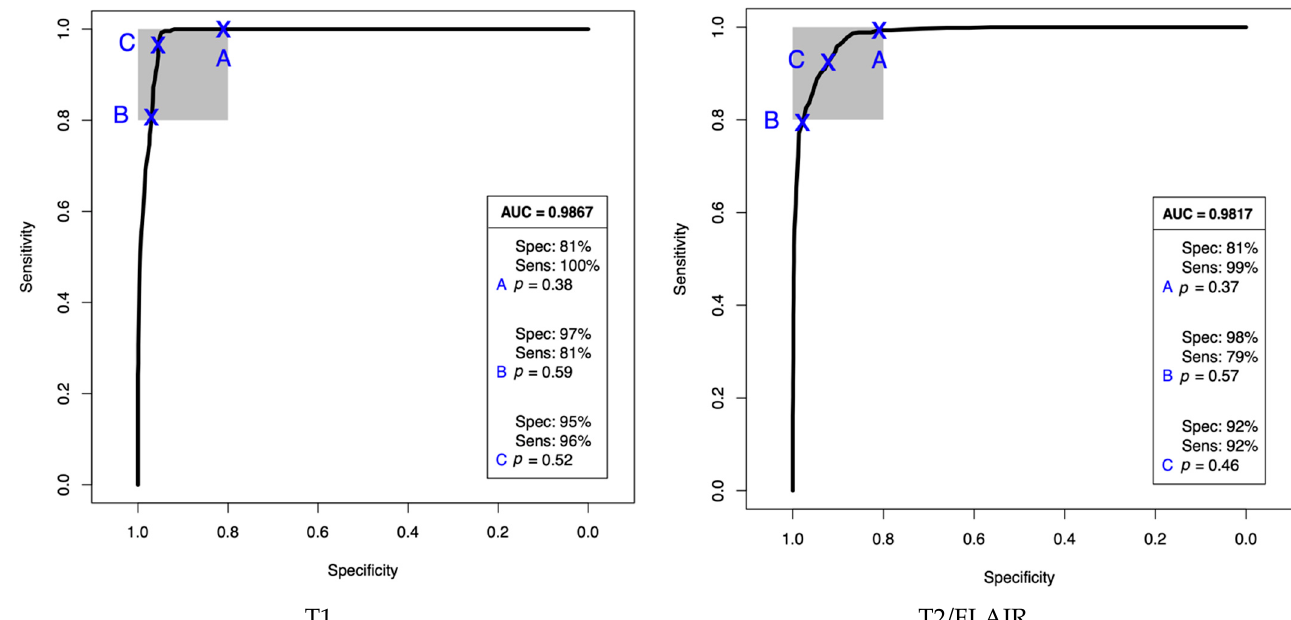
Figure 2. ROC curves with AUC for T1 and T2/FLAIR patient classification over nine repeats and 51 iterations with the partial least squares-discriminant analysis (PLS-DA) model.